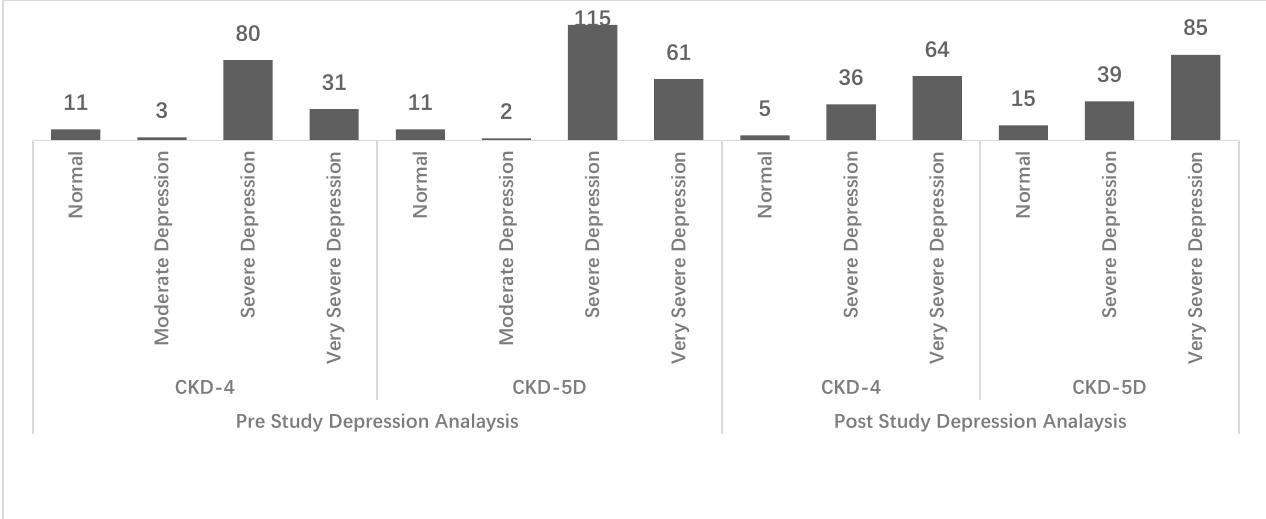
Figure 4. Depression level distribution (frequency) among study groups pre- and post-study.